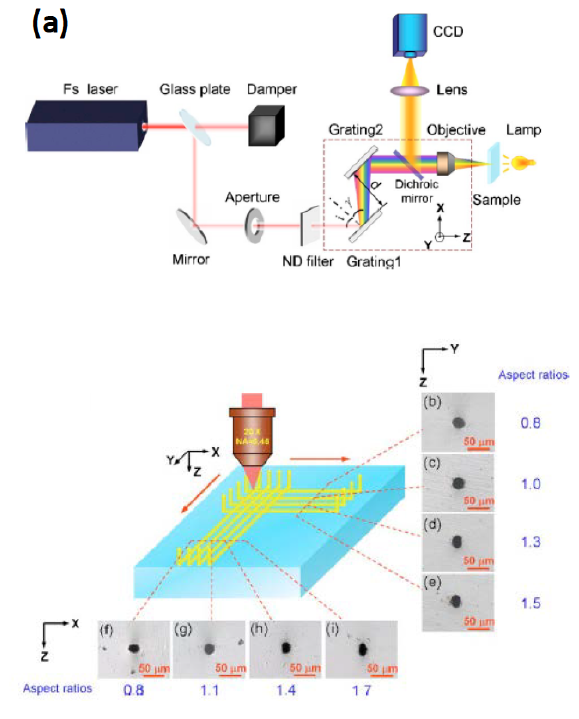
Figure 20: (a) Experimental setup for spatiotemporal focusing of a femtosecond laser beam. (b–i) Optical micrographs of the microflu- idic channel cross section. The beam sizes and laser powers are 2 mm and 4 mW in (b) and (f), 3 mm and 3.5 mW in (c) and (g), 4